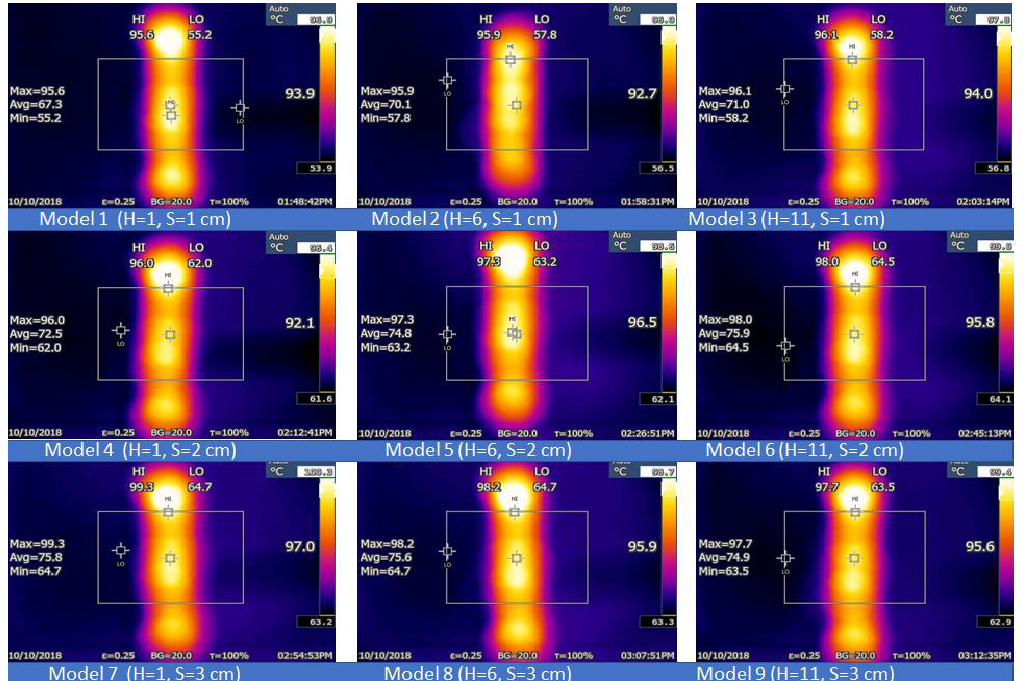
Figure 16. Thermographic distributions of the aluminum flat plate that present Models 1 to 9 at Re = 17,000.